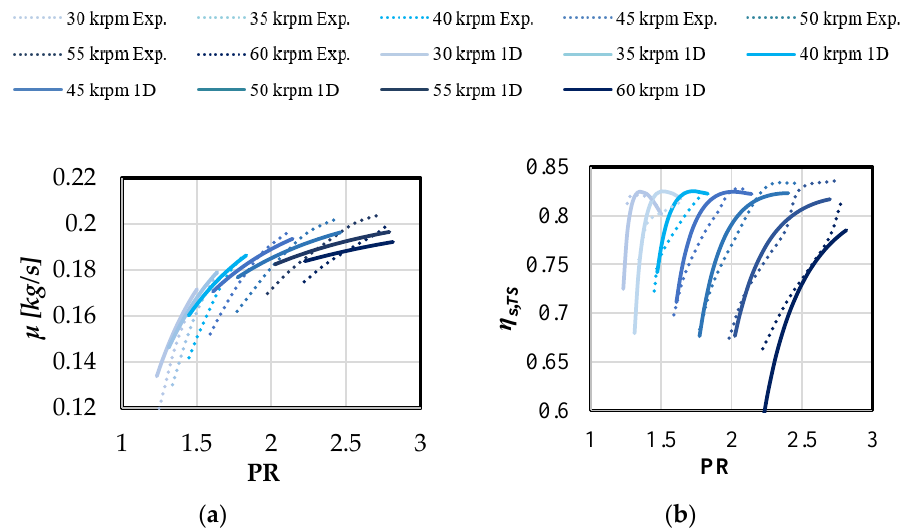
Figure 11. Results from turbine validation. ( a ) Corrected flow rate vs pressure ratio; ( b ) total to static isentropic efficiency vs pressure ratio.